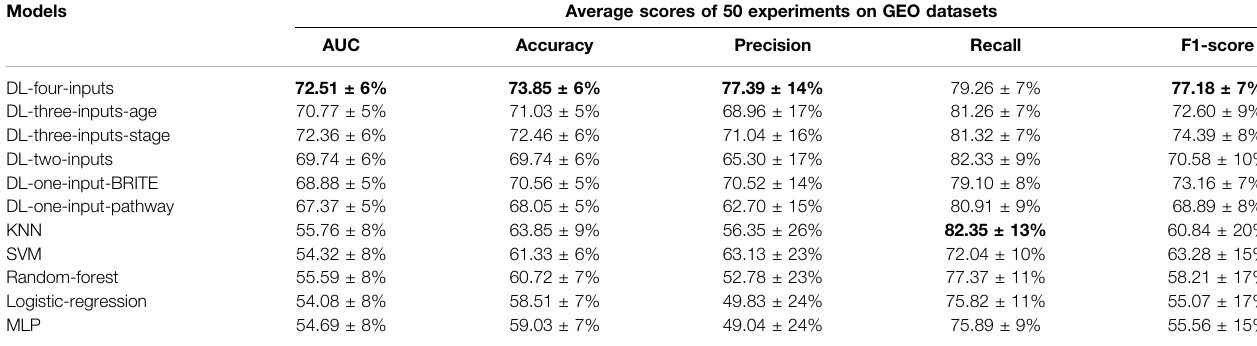
TABLE 5 | Results of the fi ve average metrics scores from 50 different train – test-split experiments (mean ± SD) on the GEO GSE37745 data set. The accuracy, precision, recall, and f1-score were calculated with the optimal threshold selected using Youden ’ s J statistic.